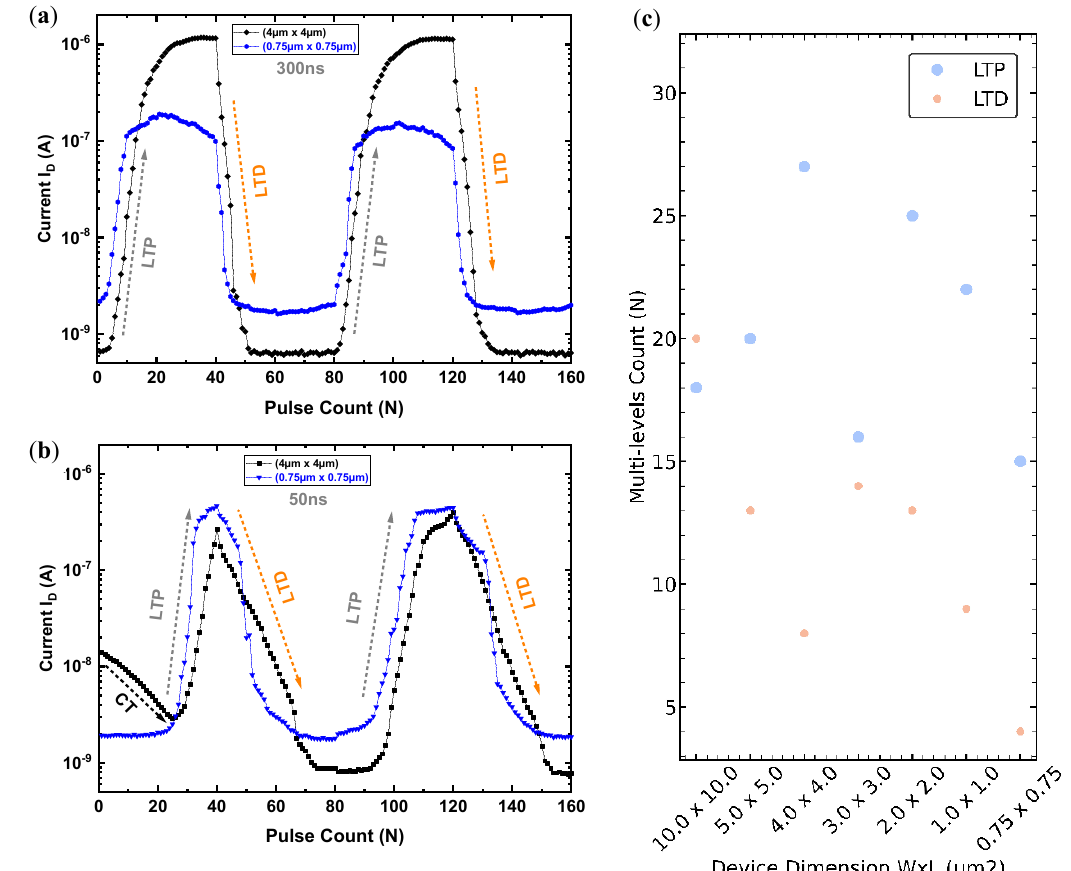
Figure 20. The comparison of the FeFET synaptic LTP/LTD using the pulse amplitude-based sequence 3 at two different pulse widths ( a ) 300 ns and ( b ) 50 ns shown for large (4 µ m × 4 µ m) versus small (0.75 µ m × 0.75 µ m) device dimensions, ( c ) the multi-level count versus the device dimension